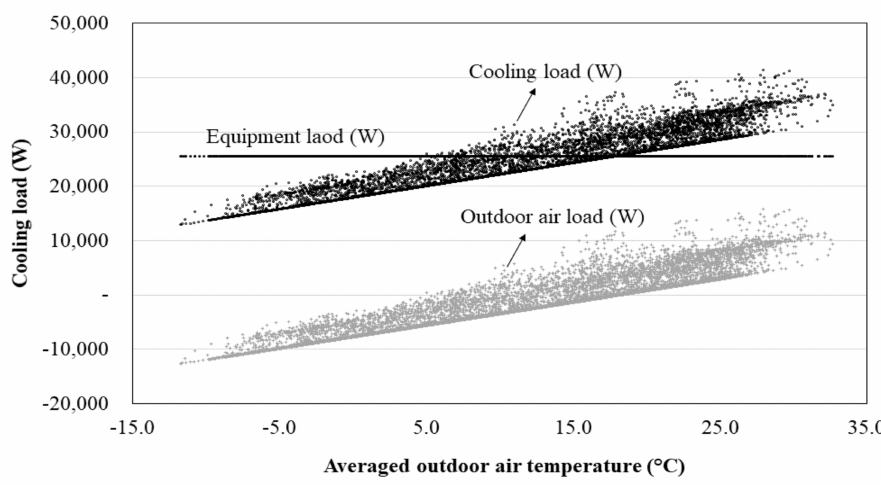
Figure 6. Variations of several related loads with the daily averaged outdoor air